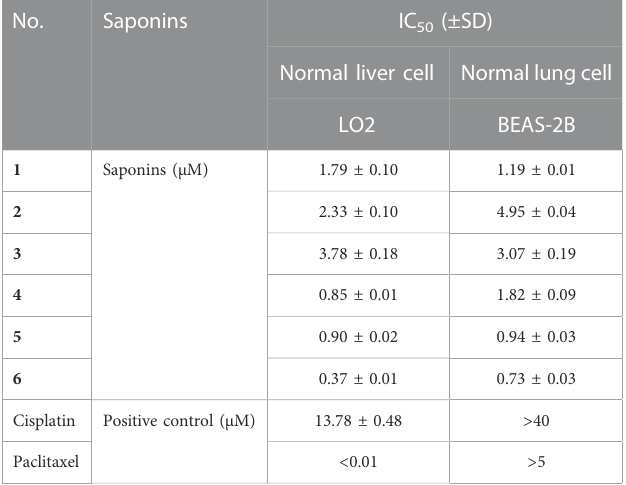
TABLE3IC 50 valuesforsaponins(1 – 6)from P.polyphylla var. yunnanensis against normal liver and lung cell lines.